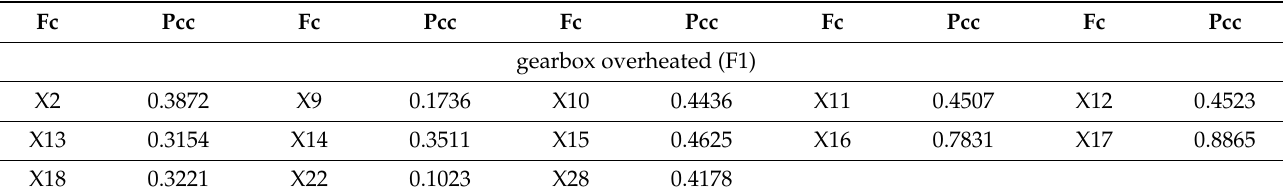
Table 7. Feature code (Fc) and its Pearson correlation coefficient (Pcc) of each